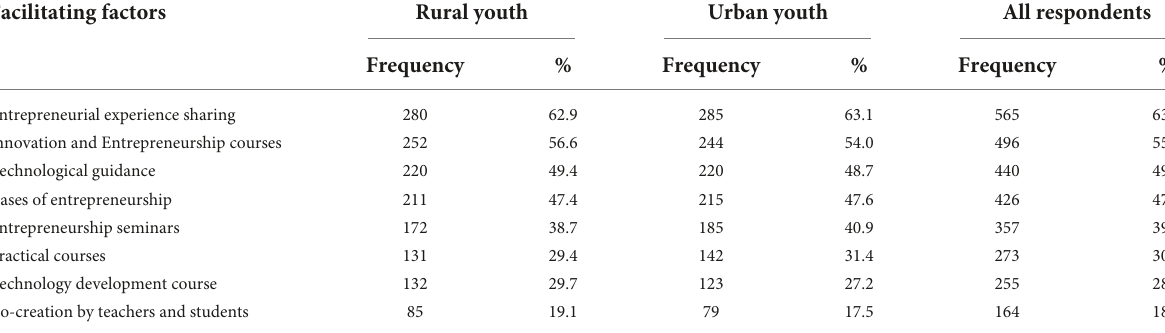
TABLE 11 Entrepreneurship courses and technology development.